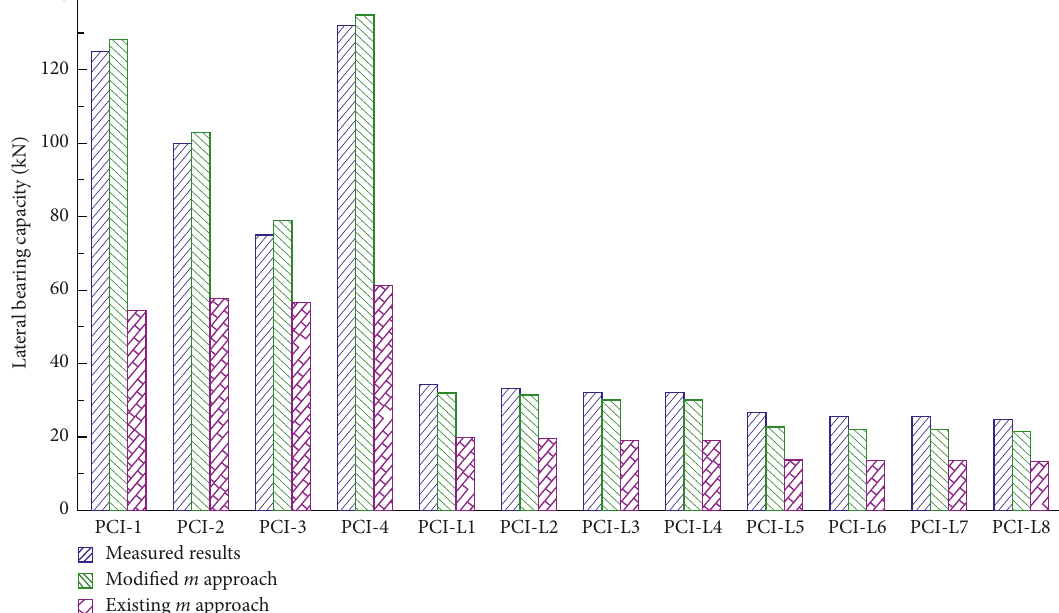
Figure 9: Comparison of lateral bearing capacity using the modified and existing m approach and measured